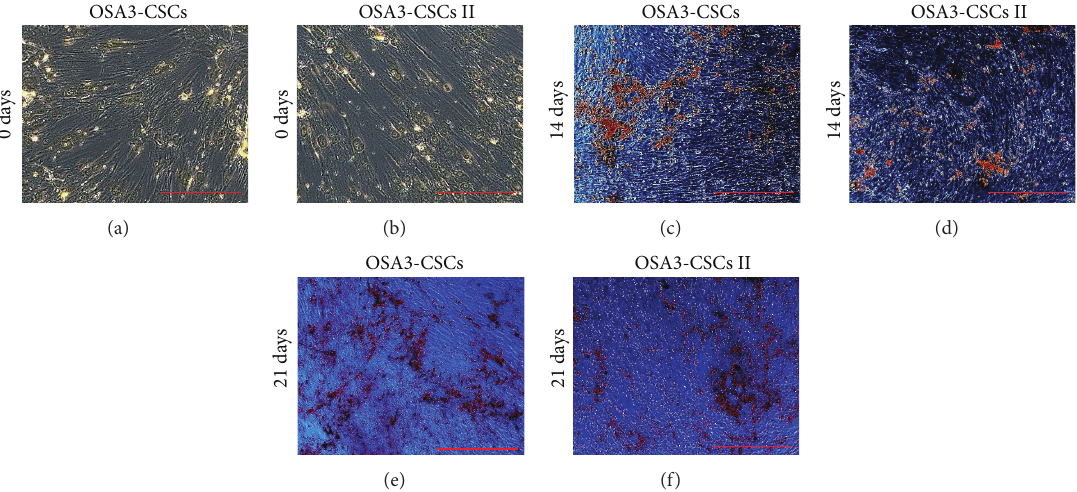
Figure 19: Osteogenic differentiation on OSA3-CSCs and on OSA3-CSCs II lines HA. Osteogenic differentiation at 0 days (a-b), after 14 days (c-d), and after 21 days of induction by a cytochemical staining for the hydroxyapatite (HA) with Alizarin Red S. The cells are only contrasted in blue/grey and the grainy deposits of HA are stained in orange/red. Observation in phase contrast. Original magnifications: 20x. Bar size: 100 𝜇